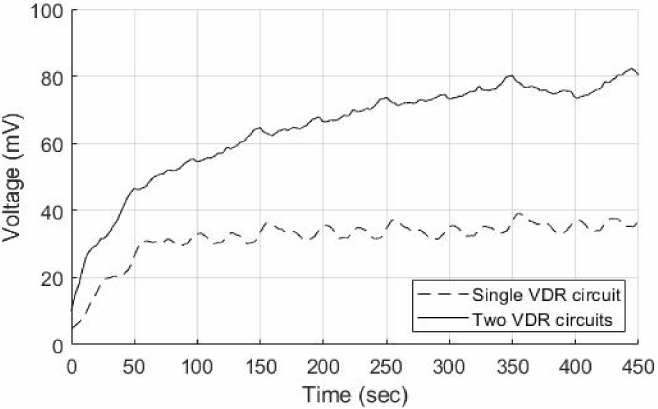
Figure A3. Output voltage of the VDR circuits connected in